Question: State the chart type depicted above.
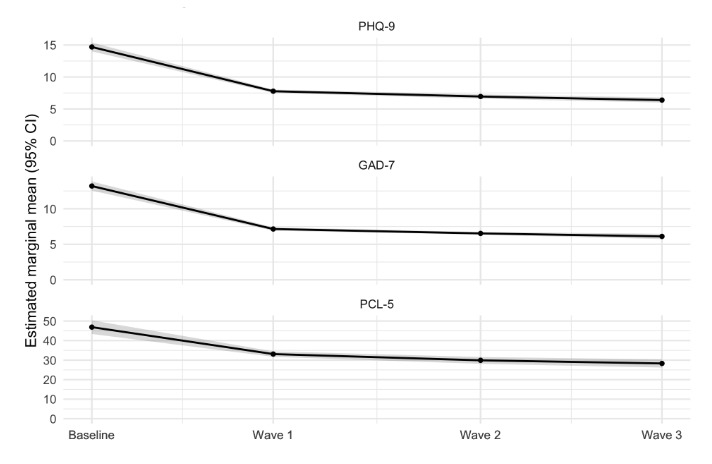
Answer: line